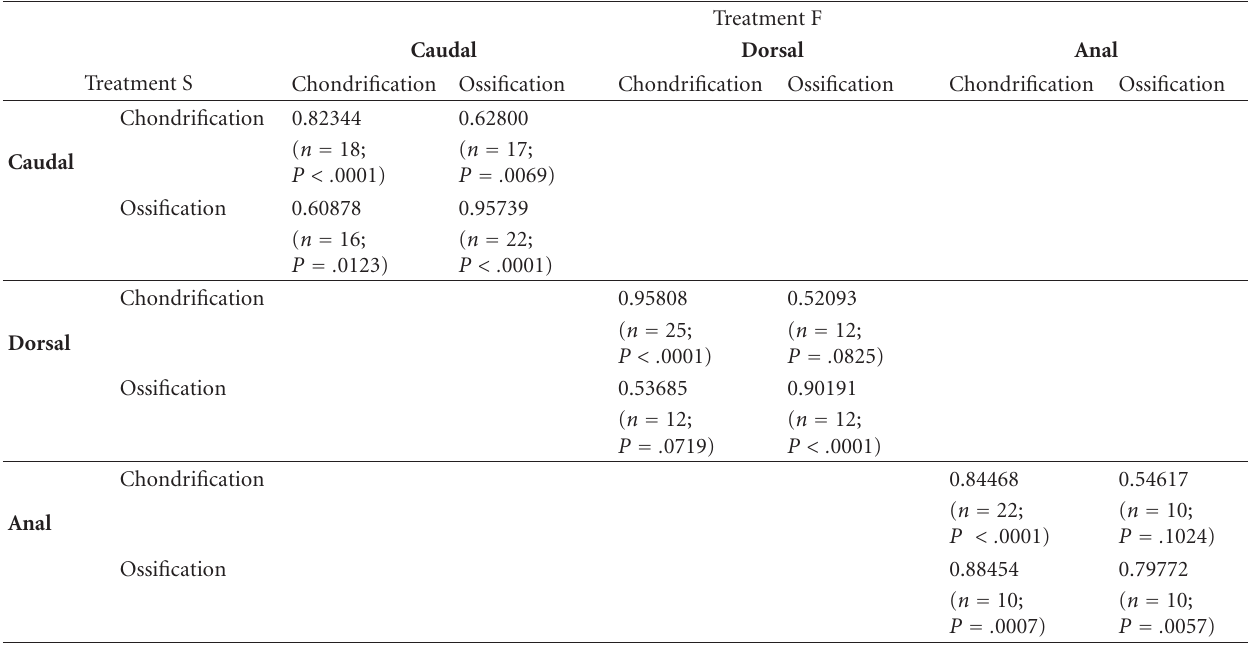
Table 2: Spearman rank correlation for the three median fins of Salvelinus alpinus reared under two treatments of water velocity (treatments S and F). n is the number of coded elements for which the time of appearance was available for both treatments (less than 90 days). P is the probability associated with a r s .